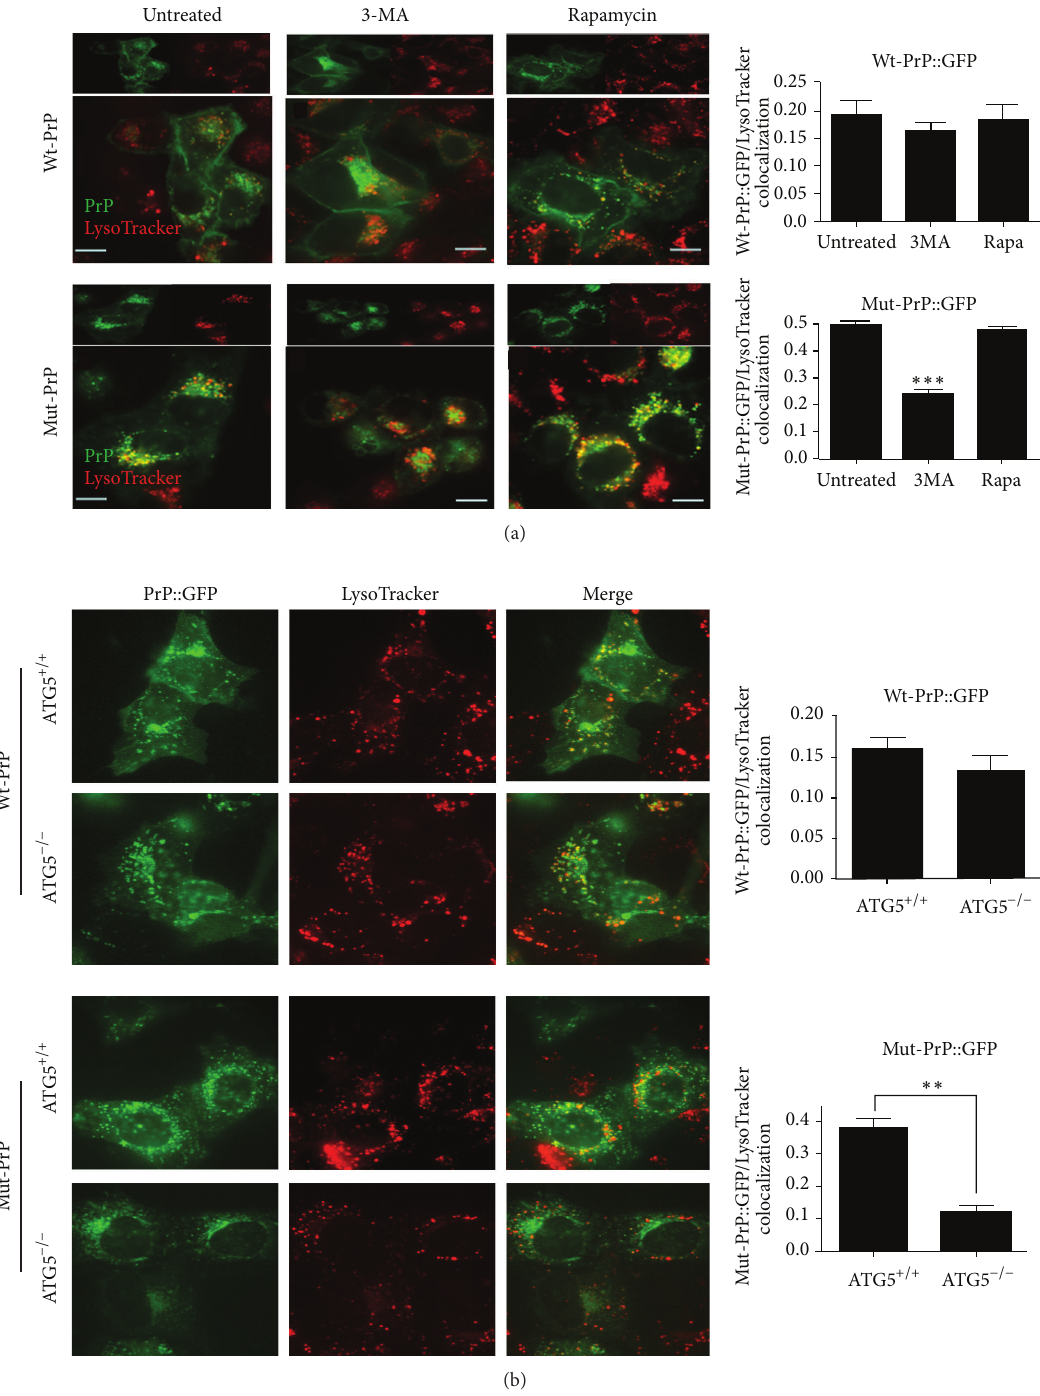
Figure 8: Autophagy participates in the delivery of Mut-PrP to LysoTracker labeled vesicles. (a) Three hours after transfection, HeLa cells expressing GFP-tagged Wt-PrP or Mut-PrP were treated for 16h with 2mM 3-MA, 2 𝜇 M rapamycin, or fresh media alone (untreated), followed by incubation with 50nM LysoTracker Red for 30min prior to live cell confocal fluorescence microscopy. Individual channels are displayed above merged images. Yellow indicates colocalization. Scale bars = 10 𝜇 m. Graphic display of Li’s correlation coefficient between Mut-PrP and LysoTracker for each treatment is shown to the right ( ∗∗∗ 𝑃 < 0.001 , student’s paired 𝑡 -test, difference from untreated, 𝑛 = 5 each). (b) Normal (ATG5 +/+ ) and autophagy-deficient (ATG5 −/− ) mouse embryonic fibroblasts (MEFs) transiently transfected with GFP- tagged Wt-PrP or Mut-PrP were allowed to express for 16h prior to confocal microscopy, performed 30min following the addition of 50nM LysoTracker Red. Single 0.5 𝜇 m slice images are shown. Each channel is displayed to the left of the merged image. Graphic display of Li’s correlation coefficient between PrP and LysoTracker Red in WT MEFs compared with ATG5 −/− MEFs is to the right ( ∗∗ 𝑃 < 0.005 , student’s 𝑡 -test, 𝑛 = 5